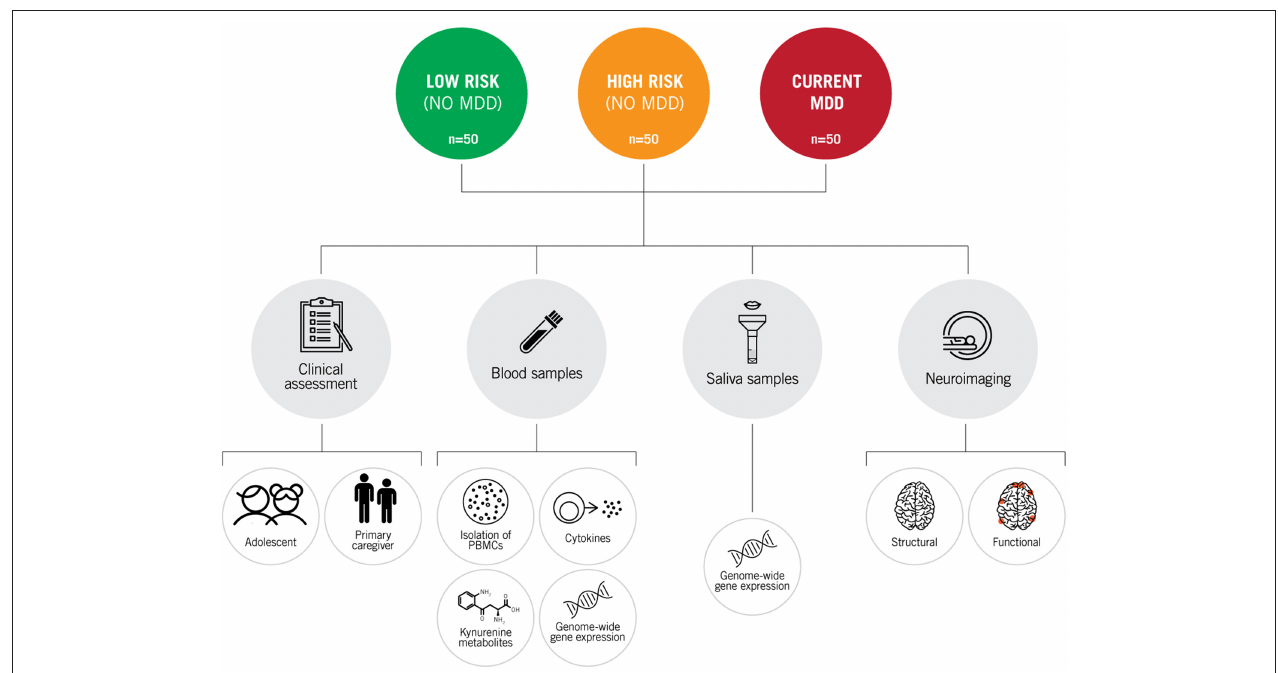
FIGURE 2 | Simplified graphic representation of the assessments and analyses performed in the IDEA-RiSCo cohort, including blood and saliva analyses such as isolation of peripheral blood mononuclear cells (PBMCs) and determination of cytokines and kynurenine metabolites and genome-wide gene expression. IDEA-RiSCo, Identifying Depression Early in Adolescence Risk-Stratified Cohort; MDD, major depressive disorder; MRI, magnetic resonance imaging; fMRI, functional magnetic resonance imaging.